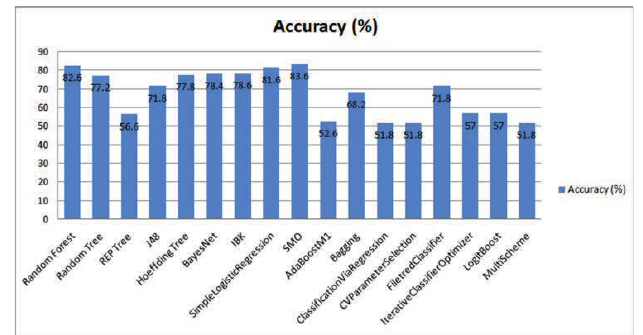
Fig. 2. Accuracy obtained for each classifier for Urdu